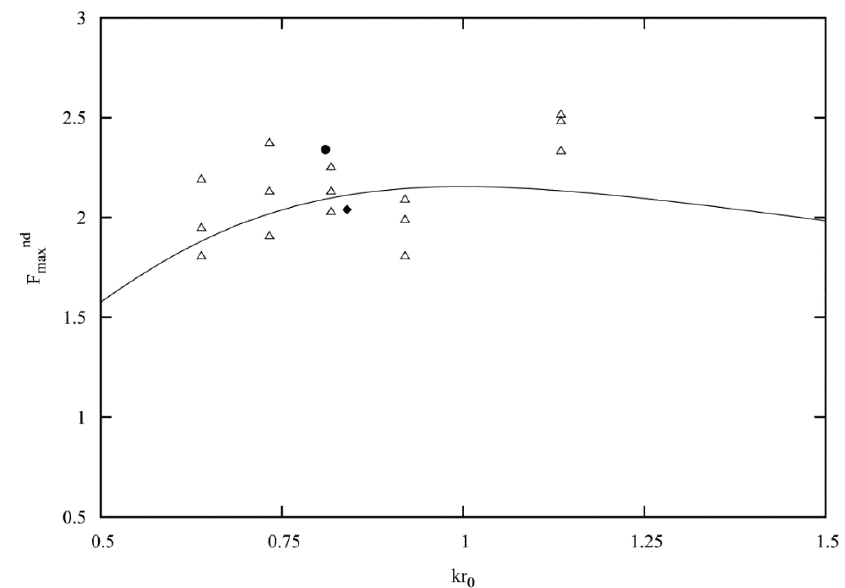
nd F ) on cylinder as a function of kr : (—) solution of MacCamy Figure 10. Force ( max 0 and Fuchs [1]; ( ♦♦ ) data from solution of Euler equations; ( ●● ) data from solution of Navier-Stokes equations; ( ∆∆ ) data from experiments of Niedzwecki and Duggal